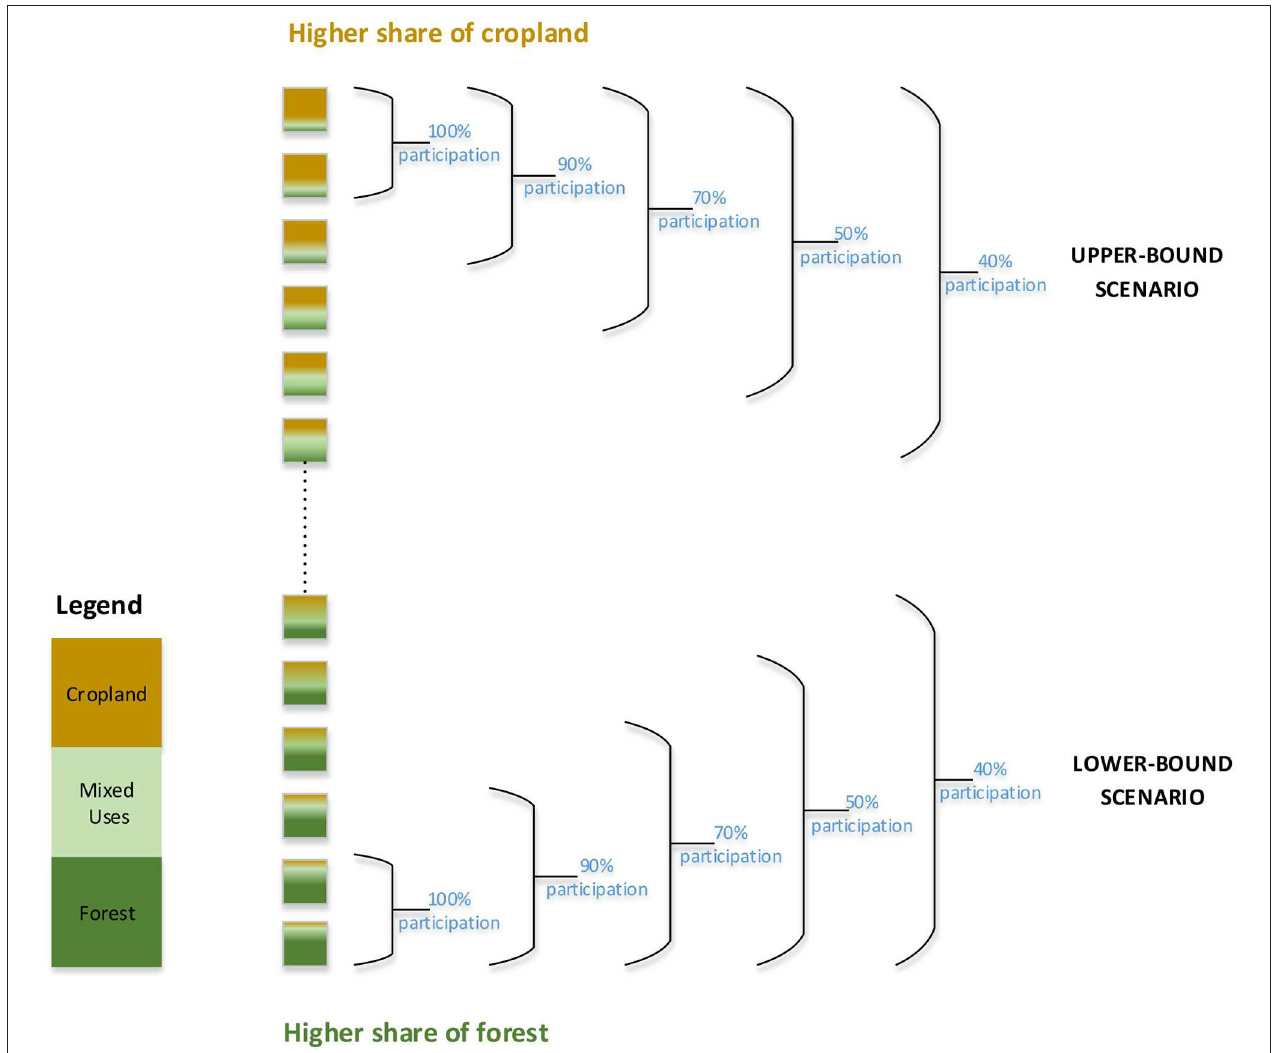
FIGURE 2 | Stylized representation of the effects of changing the uptake of restoration efforts. agricultural land and can be characterized by the ratio of agricultural land by forested area—the lower the ratio, the smaller the amount of agricultural land. In the lower-bound scenario, the grid-cells are arranged in ascending order (from smallest share to largest share of agricultural land) and as many grid- cells are included in the simulation as necessary to reach the 350 million hectares of land under restoration required by the Bonn Challenge. For the upper-bound scenario, the grid-cells are arranged in descending order and similarly, a sufficient amount is selected to meet the goal of the Bonn Challenge. In so doing, the lower-bound scenario maximizes the amount of forest involved in FLR efforts while the upper-bound scenario maximizes restoration over agricultural